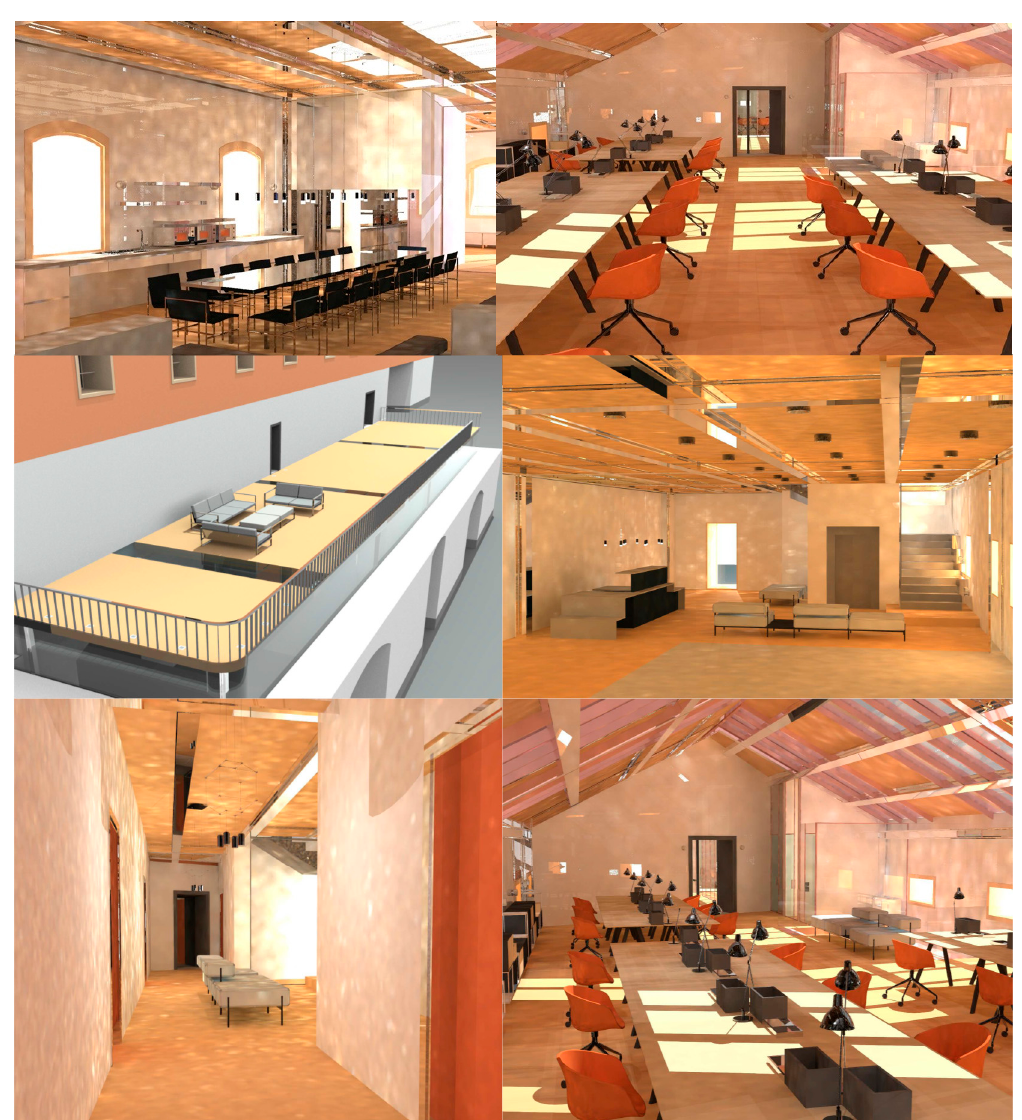
Figure 9. Interior rendering (BIM) of the proposed new-use development.